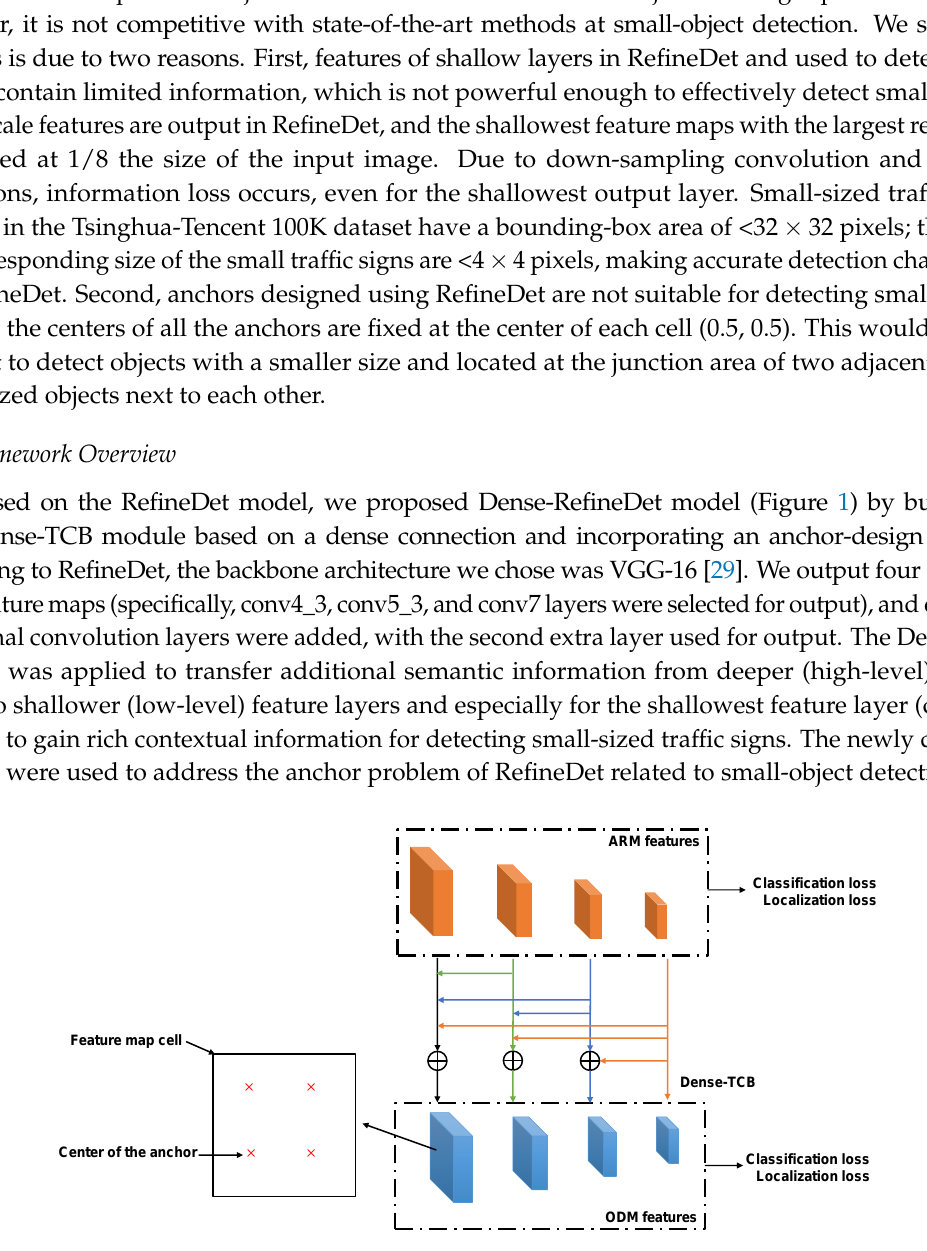
Figure 1. The framework of Dense-RefineDet model.TCB, transfer connection block. ARM, anchor refinement module. ODM, object-detection